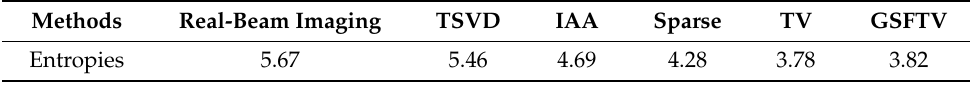
Table 4. Entropies of real data